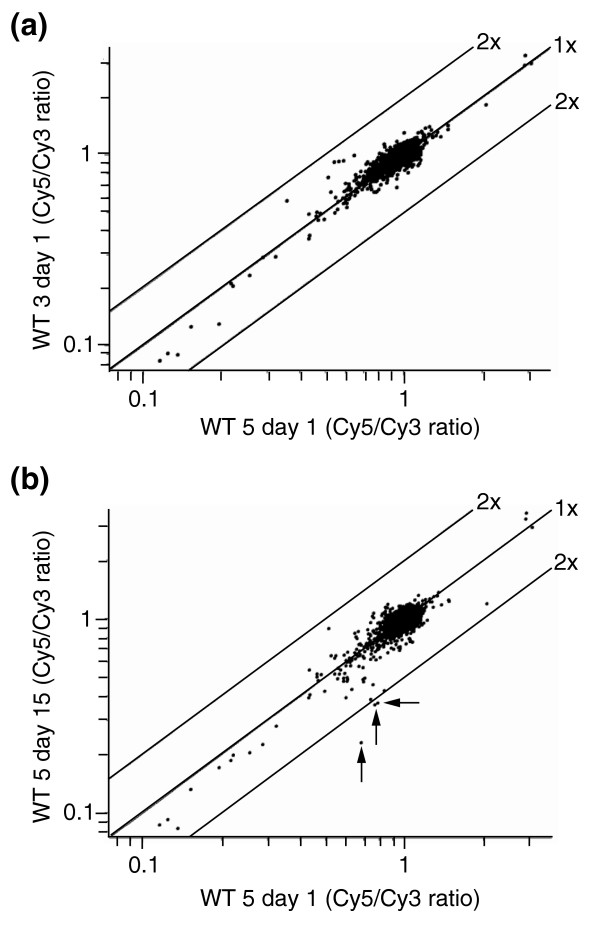
Stability of wild-type strain gene expression profiles. (a) Microarray expression data for two wild-type biological replicates, WT 3 and WT 5, on day 1 of the growth curve are plotted against each other. The expression data plotted are the normalized ratio of dyes Cy5- and Cy3-dCTP representing sample and reference pool, respectively. Lines showing limits of twofold change are drawn on both sides of the line of identity (identical values between datasets). The axes are log scale. Every gene for which there is data is shown (filled circles). All genes fall within the lines of twofold change. (b) As in (a), except WT 5 from day 1 of the growth curve is compared with WT 5 from day 15. Only three out of 5,050 genes, marked with arrows, changed expression by more than twofold. These genes are SPBC354.08c, encoding a hypothetical protein (2.15-fold); atp8+, F0-ATP synthase subunit 8 (2.15-fold); and cox1+, cytochrome c oxidase subunit I (2.98-fold).